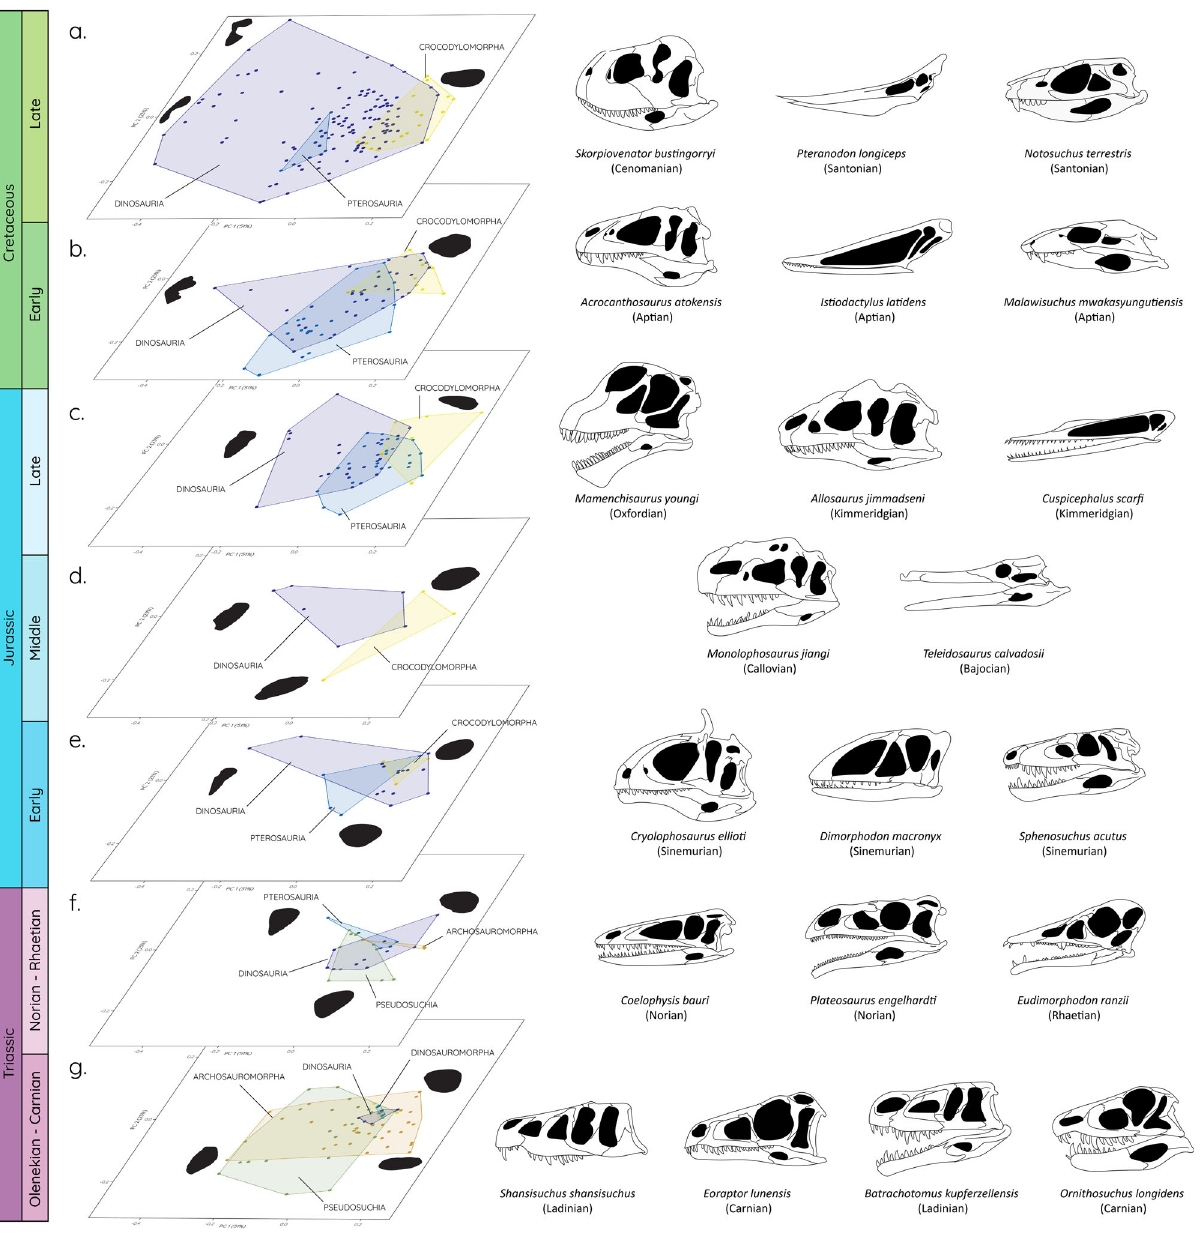
Fig. 2 Patterns of morphospace occupation through the Mesozoic. Orbital morphospace plots shown for individual time intervals ( a – g ) and selected taxa representing speci fi c orbit shapes (skull images redrawn based on respective specimen references detailed in the supplementary data